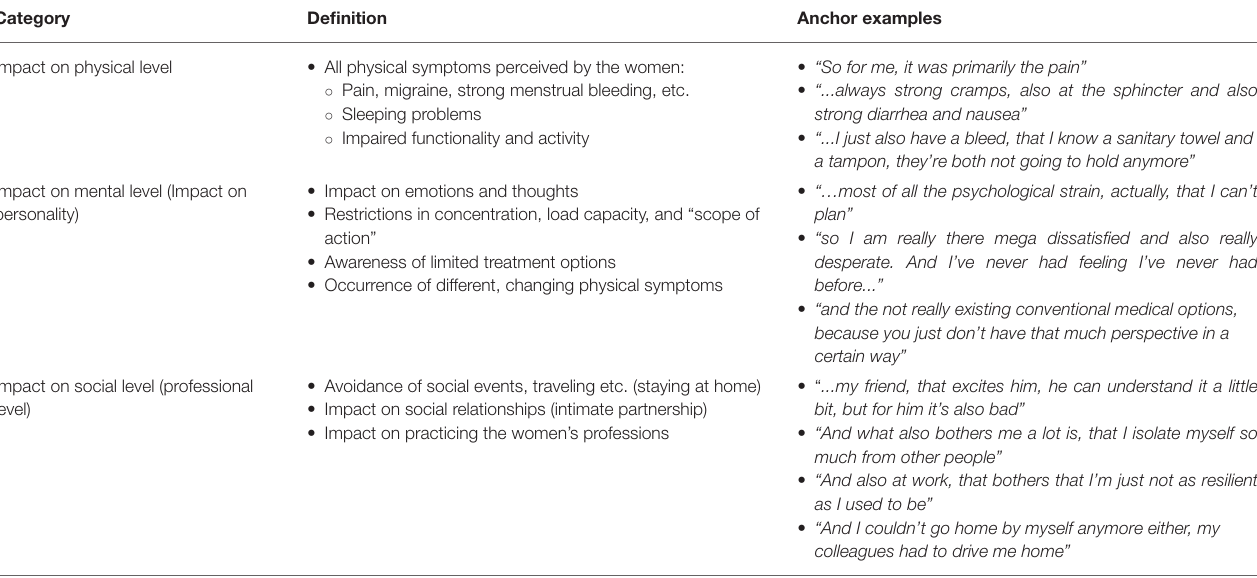
TABLE 4 | Interview analysis guide and